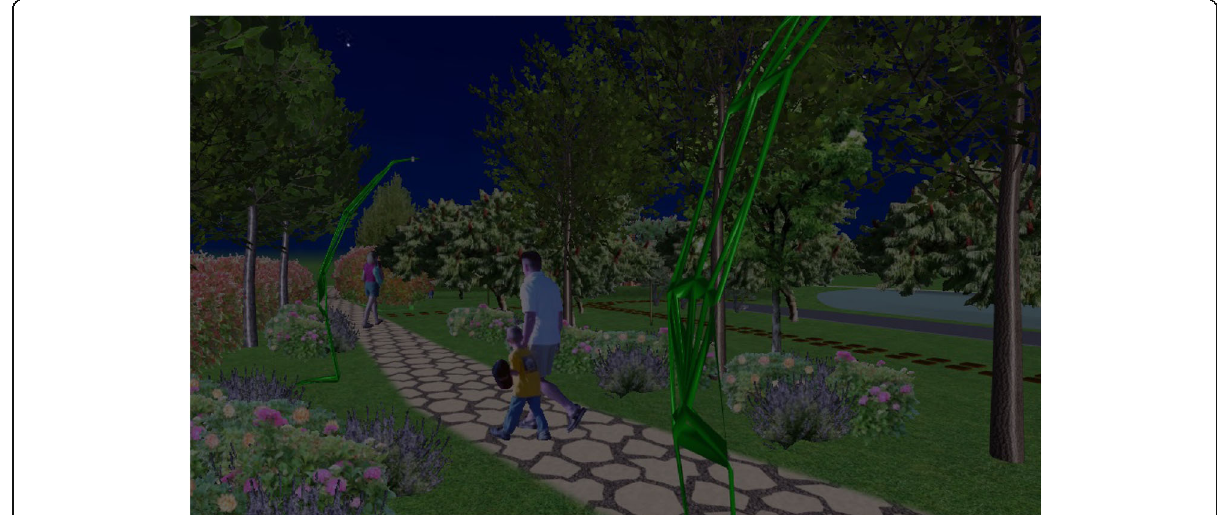
Fig. 14 Candelabra model in nighttime